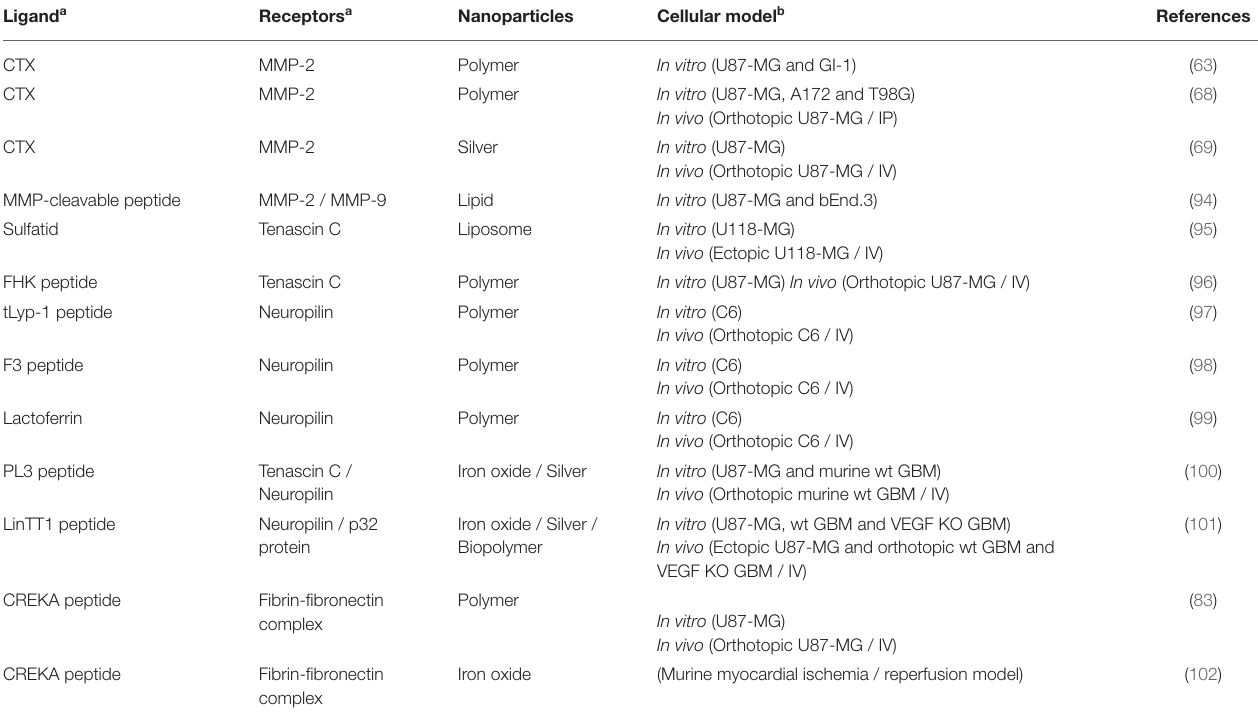
TABLE 4 | Selection of ligands for extracellular matrix targeting, with the corresponding receptors. Ligand